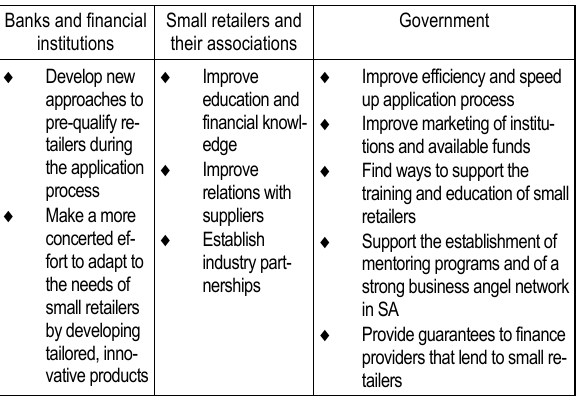
Table 3. Suggestions for stakeholders to